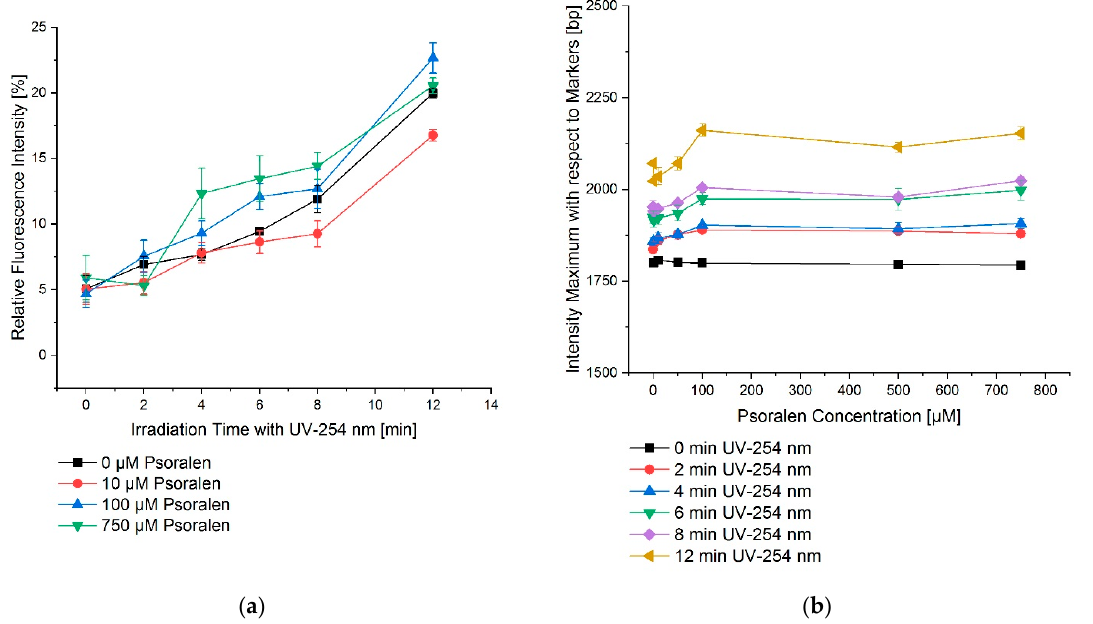
Figure 3. UV irradiation time–effect relations for the combination of psoralen with UV-254 nm. ( a ) OC fraction as a function of irradiation time, ( b ) OC fraction as a function of psoralen concentration. The effects are displayed as changes in the migration distances of DNA in relation to the markers bp. To increase the irradiation time, the effect as in relative fluorescence intensity also increased. However, this effect was nearly concentration independent. The error bars show the